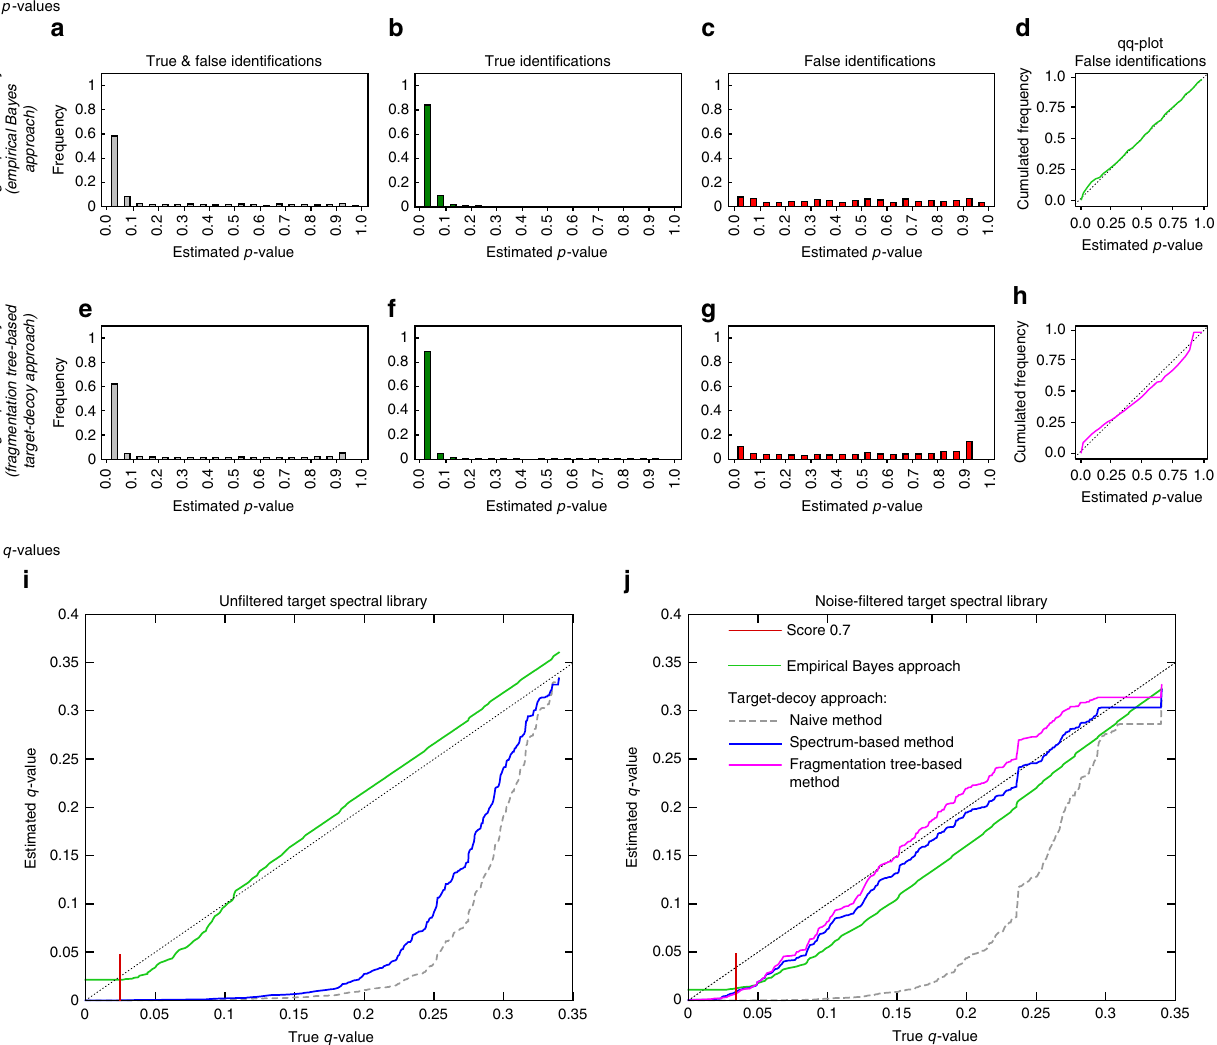
Fig. 2 Quality assessment for FDR estimations for Agilent query spectra to the GNPS library using MassBank scoring function. a – h p -values. Distribution of p -values. For searching in the un fi ltered target spectral library a – d , p -values are estimated using the empirical Bayes approach. For searching the noise- fi ltered target spectral library, p -values are estimated using the fragmentation tree-based target-decoy approach e – h . Distributions contain p -values from ten decoy spectral libraries. p -value distribution for both, true and false hits a , e , p -value distribution for true hits only b , f , and for false hits only c , g . By de fi nition, the distribution of p -values for false hits has to be uniform, corresponding to the main diagonal in the p -value quantile-quantile (qq) plots d , h . The qq plots for the other methods are provided as Supplementary Fig. 1. i , j q -value plots for Agilent data ( q -value plots for MassBank are provided as Supplementary Fig. 2). Estimated ( y -axis) vs. true q -values ( x -axis) in the un fi ltered i and noise- fi ltered j version of the GNPS library. The small red line indicates cosine of 0.7. For the fragmentation tree-based method, we searched against the noise- fi ltered GNPS only, since this approach applies noise- fi ltering by design. The naive target-decoy approach can be seen as baseline method for comparison. For target-decoy methods, results were averaged over ten decoy spectral libraries (Supplementary Fig.